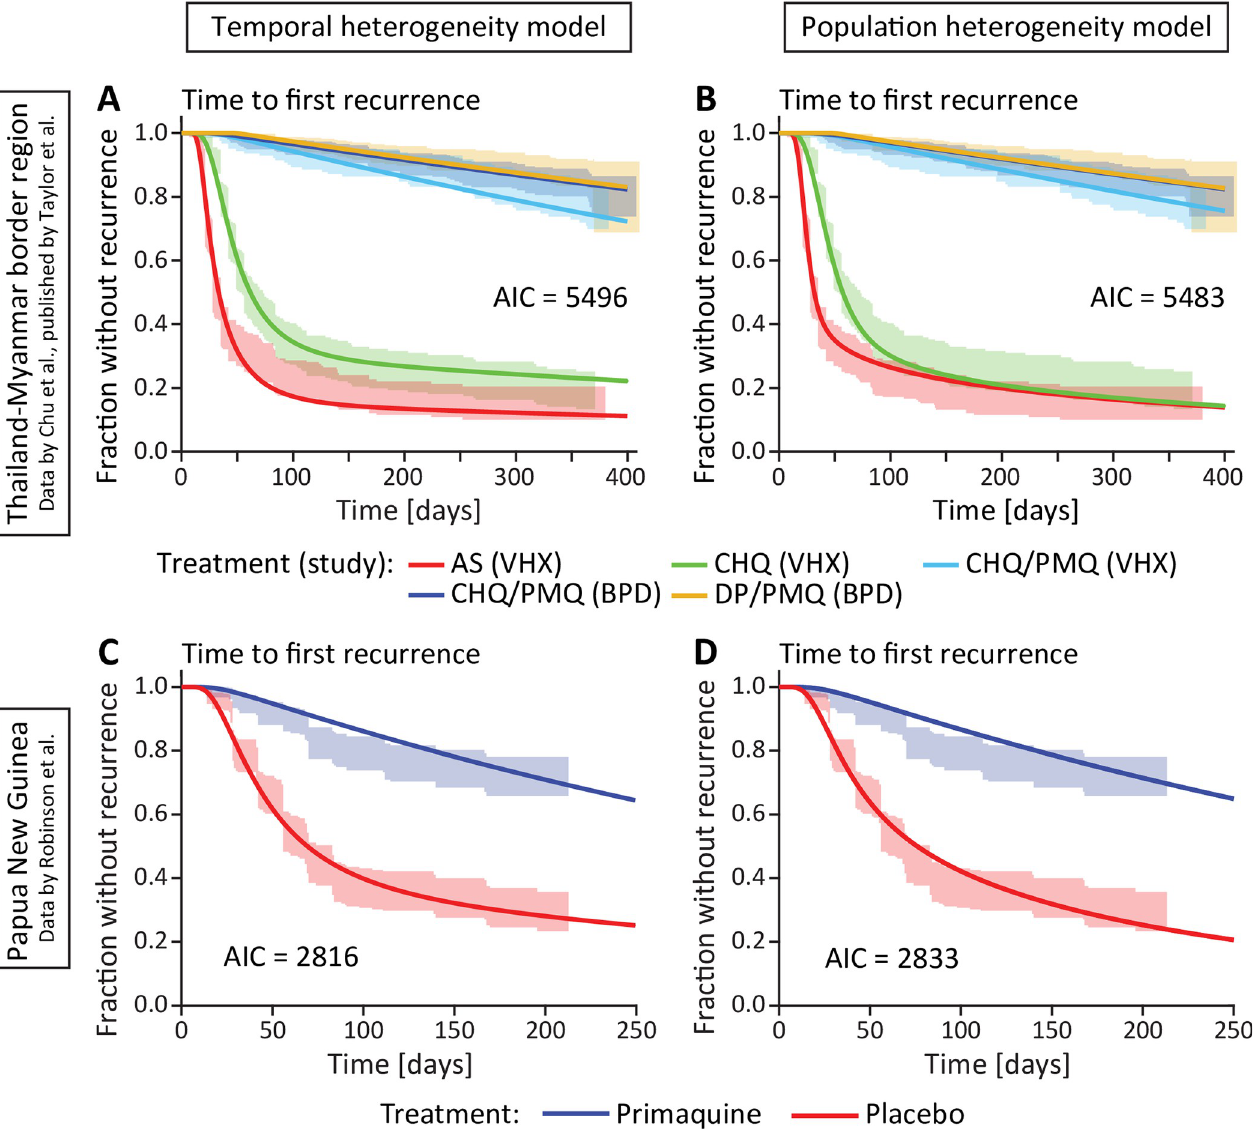
Fig 2. Fitting models of temporal and population heterogeneity to the data. The left column ( A and C ) shows the fit of the temporal heterogeneity model and the right column ( B and D ) shows the fit of the population heterogeneity model. The lines are the models fitted to the data and the shaded areas are the 95% confidence regions from the data. The models were fitted using a maximum likelihood approach (see Methods). ( A , B ) Fit of the heterogeneity models for each antimalarial treatment and study in the Thailand-Myanmar data. Abbreviations: AS artesunate, CHQ chloroquine, CHQ/PMQ chloroquine and primaquine, DP/PMQ dihydroartemisinin-piperaquine and primaquine, VHX Vivax History study, BPD best Primaquine Dose study. ( C , D ) Fit of the heterogeneity models to all Papua New Guinea data. For a fit to the Papua New Guinea data grouped by village see Figs C and D in S1 Figs. https://doi.org/10.1371/journal.pntd.0010990.g002 PLOS NeglectedTropical Diseases | https://doi.org/10.1371/journal.pntd.0010990 December19,